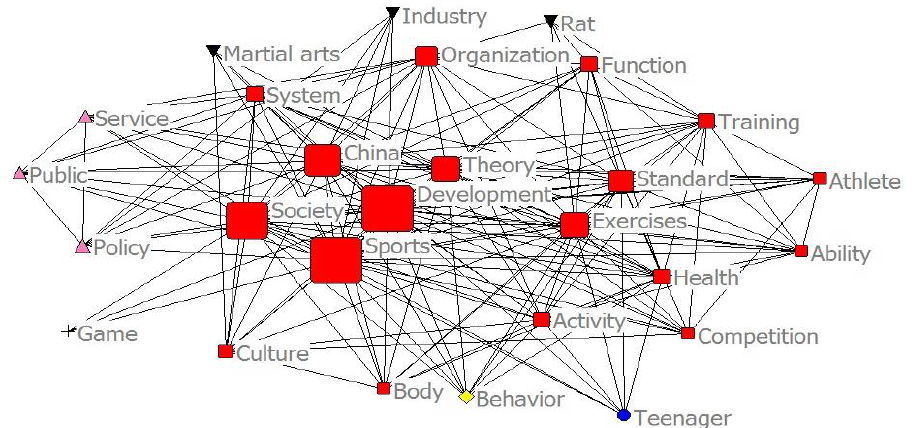
Figure 4. Network diagram for